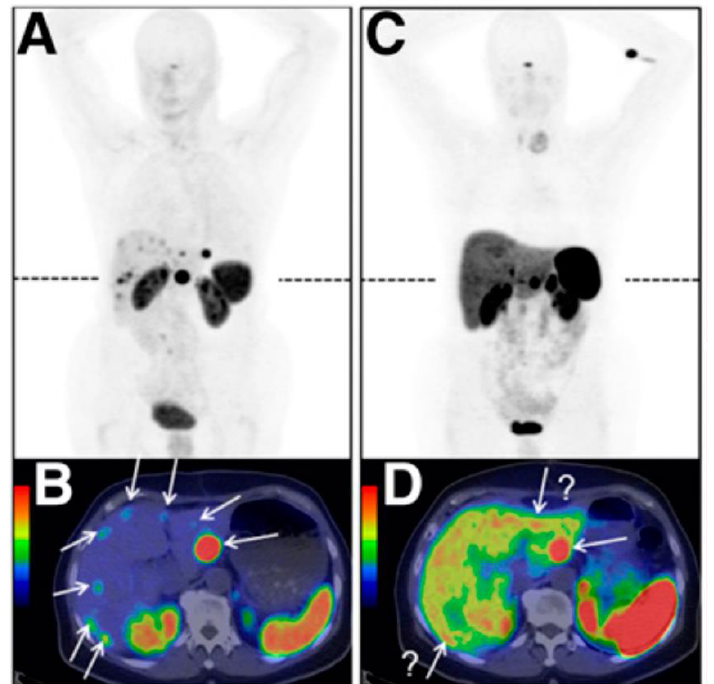
Figure 13. Comparison between [ 68 Ga]-OPS202 ( A , B ) and [ 68 Ga]-DOTATOC ( C , D ) PET / CT images of the same patient with ileal neuroendocrine tumours, showing bilobar liver metastases (from Rangger et al. [233]).